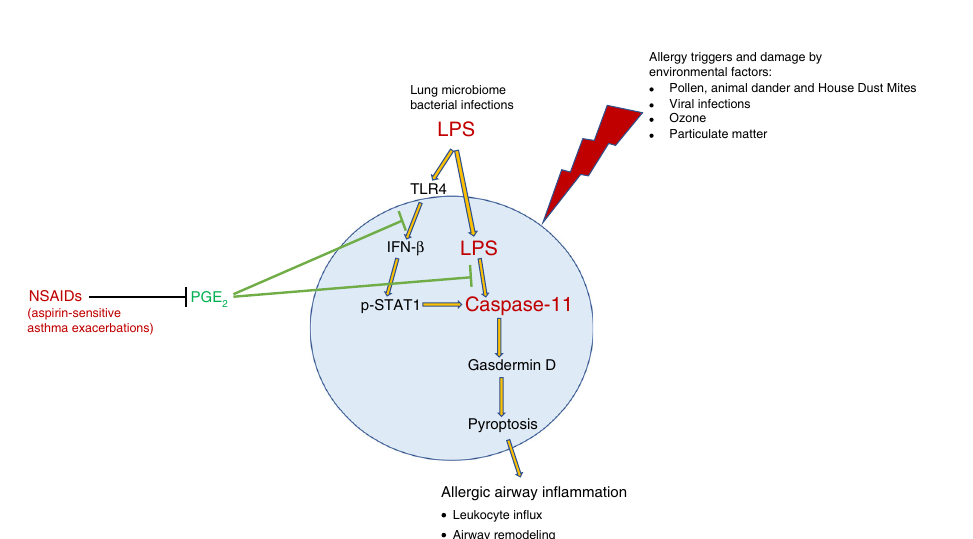
Fig. 6 Schematic representation of the protective role of PGE2 in inhibition of caspase-11 and allergic airway in fl ammation. In the lung, extracellular LPS from the lung microbiome or Gram-negative bacterial infections triggers LPS signaling, which induces IFN- β production. IFN- β in turn activates STAT-1, which gets phosphorylated and initiates transcription of caspase-11. Intracellular LPS activates caspase-11, which initiates a highly in fl ammatory process of cell death termed pyroptosis. Pyroptosis is therefore likely to participate or even initiate allergic airway in fl ammation. PGE 2 can inhibit IFN- β production and caspase-11 transcription, as well as caspase-11 activation by LPS, thereby limiting